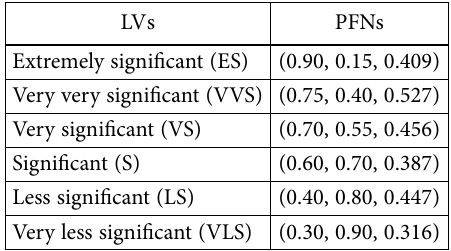
Table 2. LVs for evaluating the performance of attribute